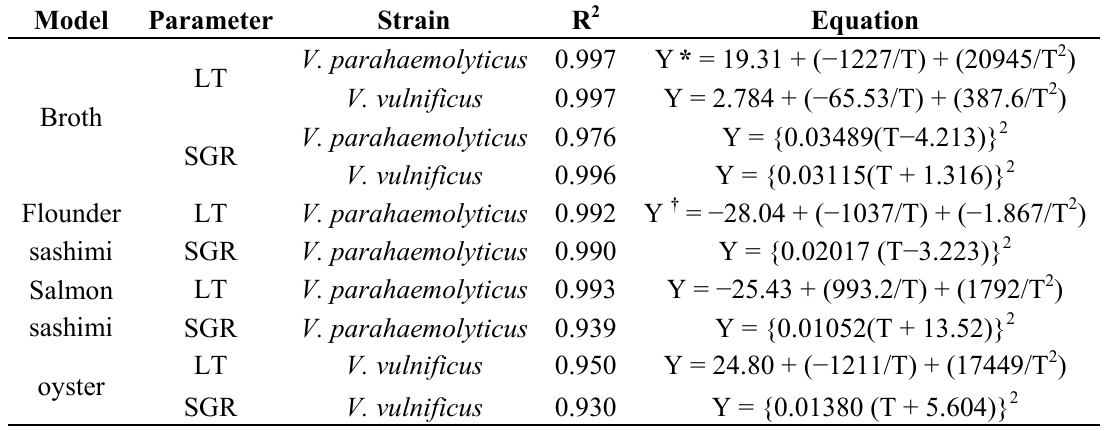
Table 2. Model for lag time (LT) and specific growth rate (SGR) of V. parahaemolyticus and V. vulnificus in broth, sashimi, and oyster.